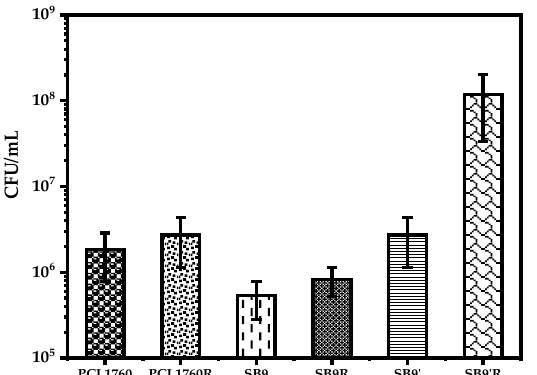
Figure 7. Generation of persister cells of PCL170 strains. PCL1760, PCL1760R, SB9, SB9R, SB9’, SB9’R as a wild type PCL1760, a wild type PCL1760 pretreated with L-rhamnose, the rsf S gene deleted mutant of PCL1760, SB9 pretreated with L-rhamnose, the complementary recombinant of SB9, and complementary recombinant of SB9 pretreated with L-rhamnose, respectively. Data are represented as mean ± SD.